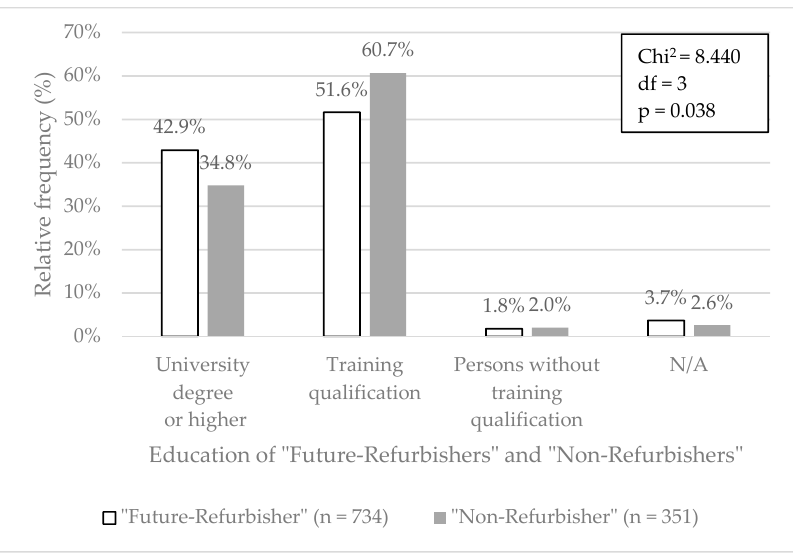
Figure 2. Education levels of “Future-Refurbishers” and “Non-Refurbishers”.